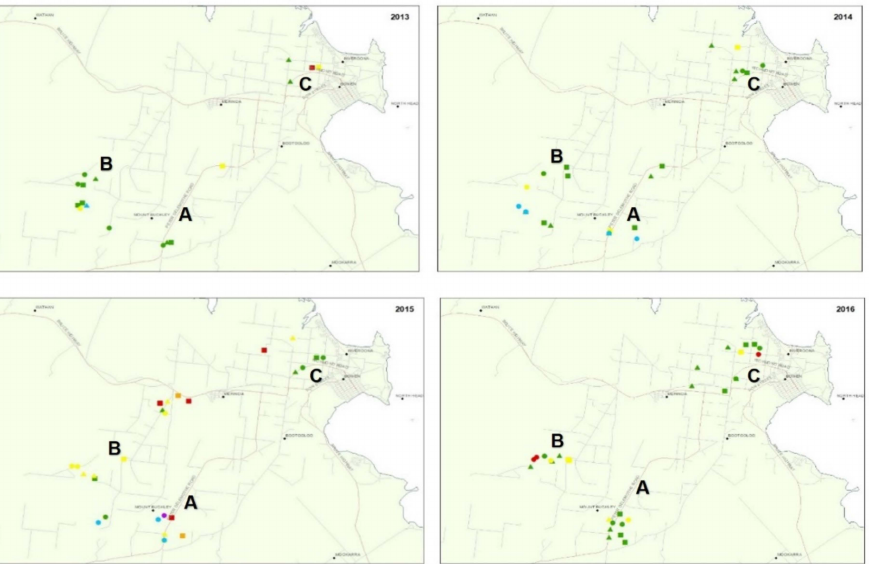
Figure 2. Distribution and population density of silverleaf whitefly (SLW) in the study area for years 2013 -2016. The three distinct survey areas are denoted as A, B, and C. Survey time points during the season are depicted as early = dot, mid = triangle, and late = square and population densities by number of adult SLW per leaflet indicated in brackets and colour coded with no SLW = purple, very low (0.01–0.09) = light blue, low (0.1–1.0) = green, mod (1.1–3.0) = yellow, high (3.1–5.0) = orange, very high (>5.0) =